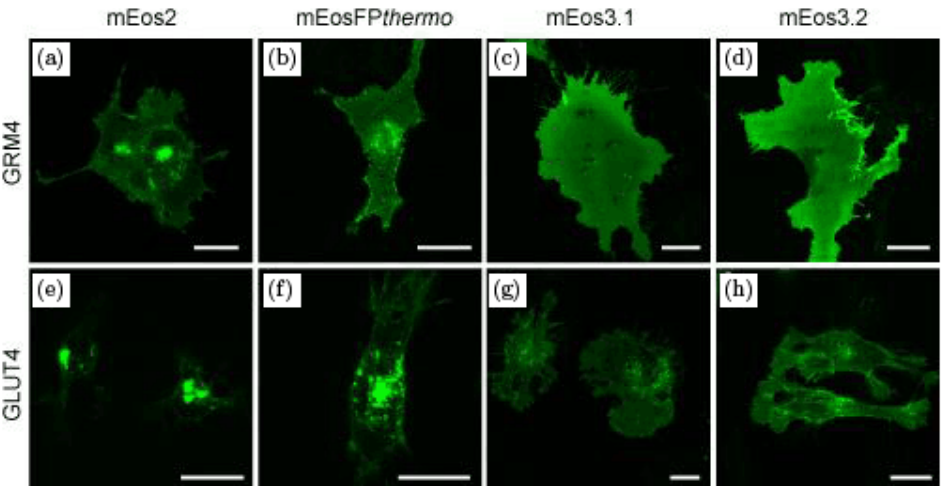
Fig. 1. (a – d) COS-7 cells expressing metabotropic glutamate receptor 4 (also known as GRM4) fused with mEos2 (a), mEosFPthermo (b), mEos3.1 (c) and mEos3.2 (d) were imaged using confocal microscope near the bottom of the membrane. (e – h) GLUT4 (glucose transporter type 4) were labeled with mEos2 (e), mEosFPthermo (f), mEos3.1 (g) and mEos3.2 (h) and transfected into L6 cells. This ¯gure is from Ref.